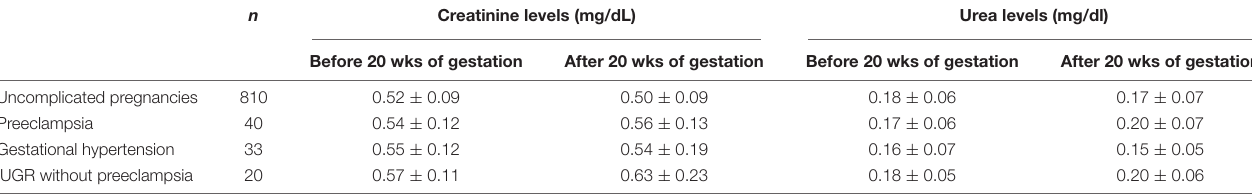
TABLE 3 | Serum urea and creatinine levels in the studied population.